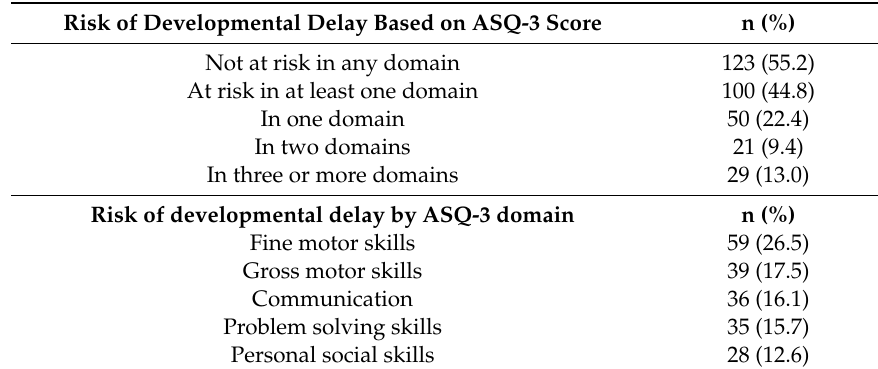
Table 3. Percentage of children at risk of developmental delay based on their ASQ-3 scores (n =